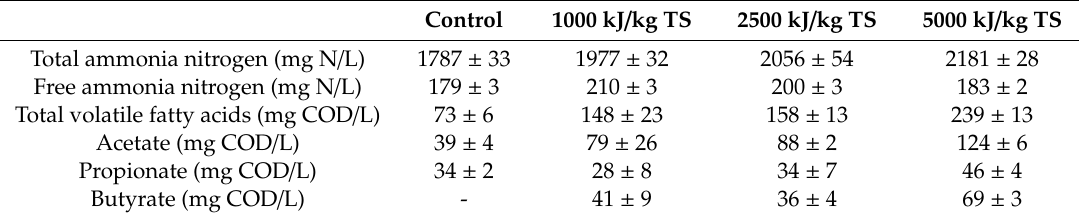
Table 2. Nitrogen and volatile fatty acids concentrations in the final digestate from BMP test. COD: chemical oxygen